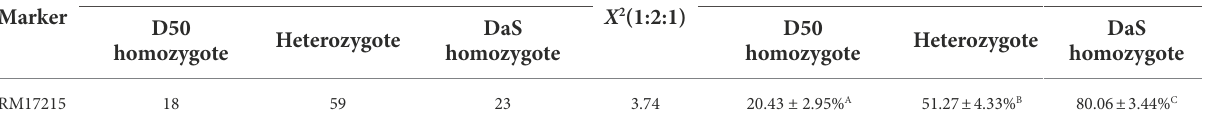
TABLE 2 Marker segregation and total stigma exsertion rate in the BC 4 F 2 population.